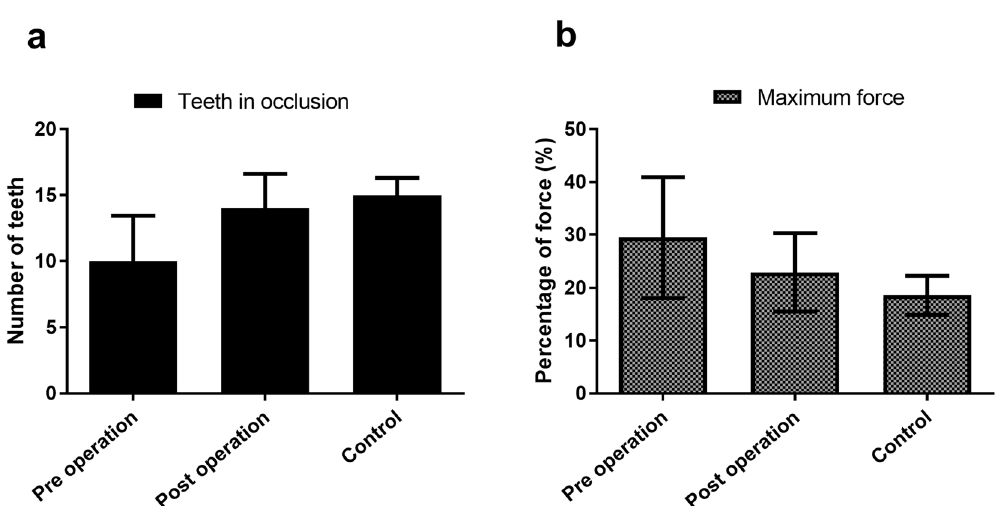
Figure 3. Comparison of ( a ) the number of teeth in occlusion and ( b ) maximum percentage force on